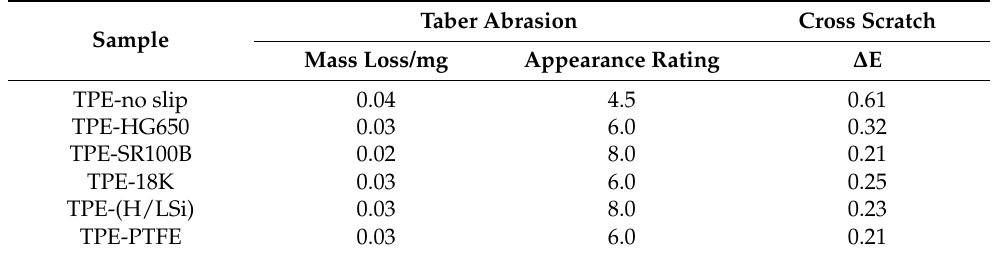
Table 12. Wear resistance of TPE prepared by various lubricating agents and masterbatches. Taber Abrasion Cross Scratch Sample Mass Loss/mg Appearance Rating ∆